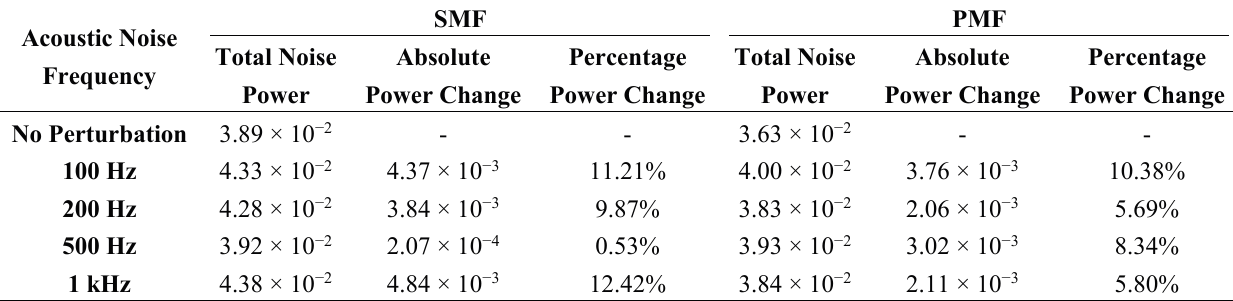
Table 1. Total excess phase noise powers at different perturbation